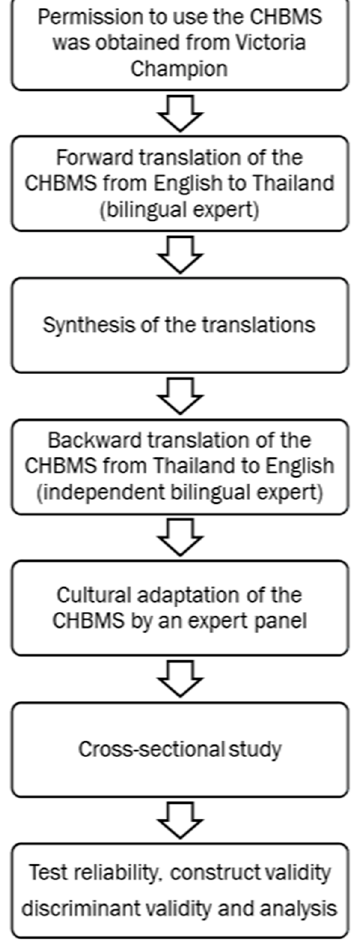
Figure 1. Cultural adaptation, translation, and validation of CHBMS.